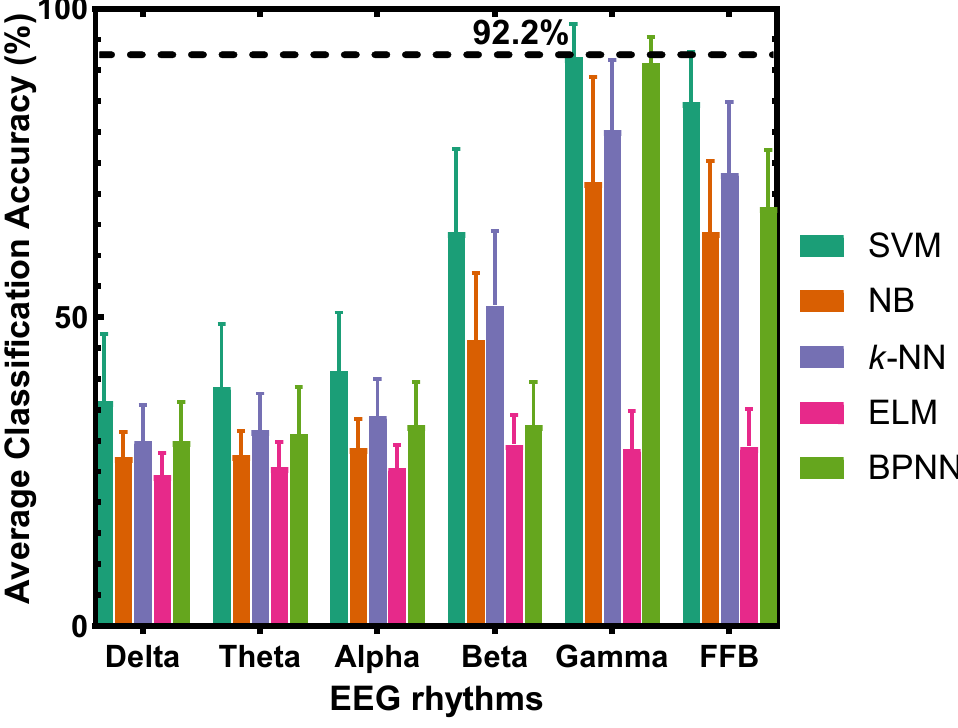
Figure 5. Classification results across concentrations of all participants on the five disgust emotions induced by the rotten odor.